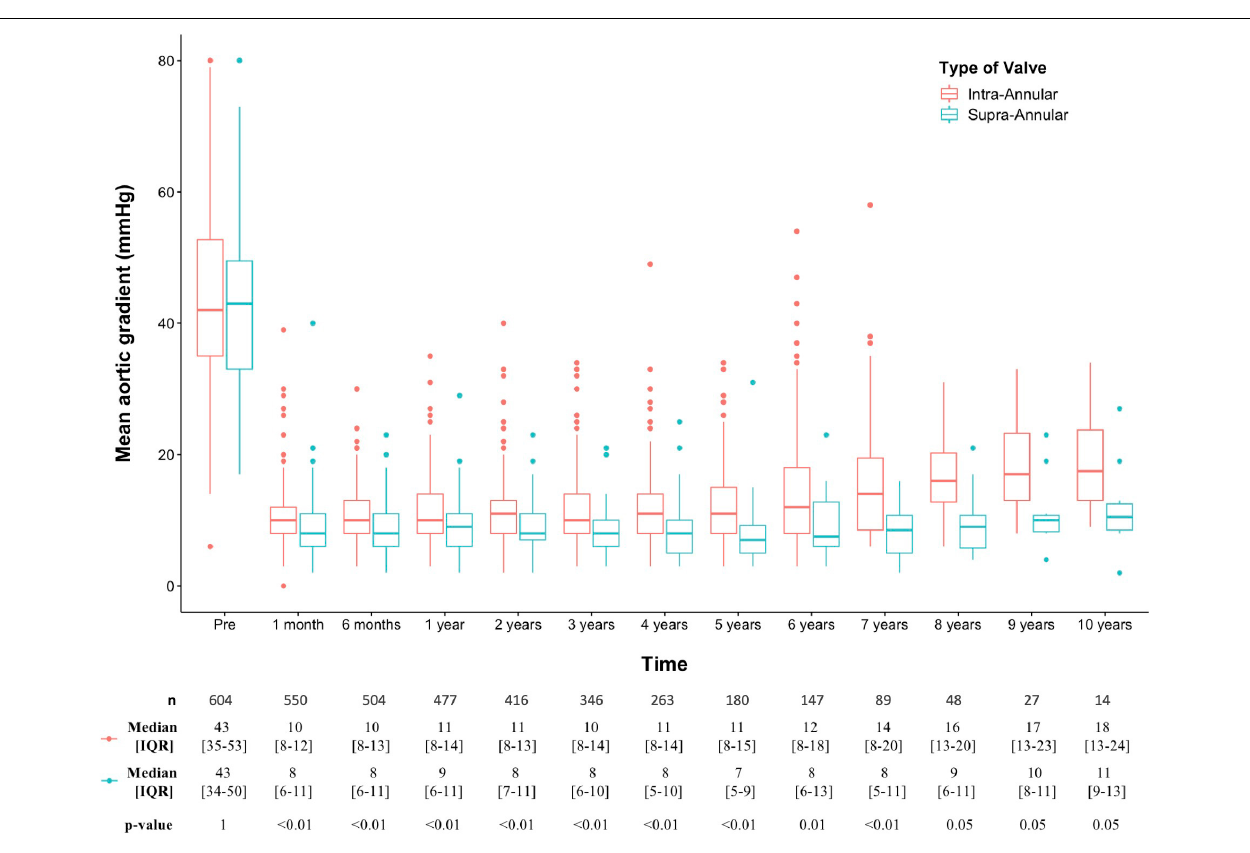
1%, Gray’s test p = 0.40) showed a similar trend compared to